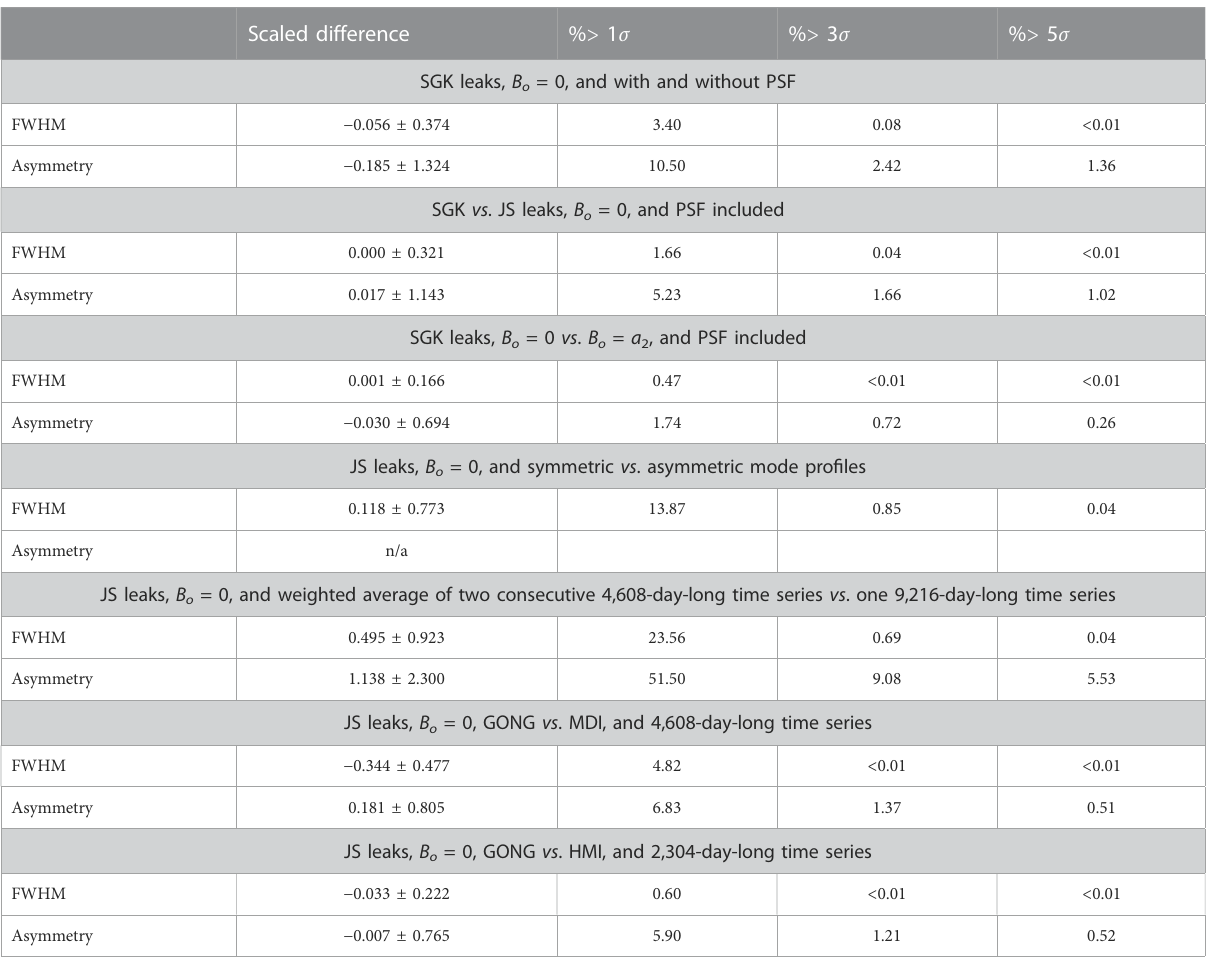
TABLE 2 Overall statistics when comparing mode characteristics derived using different fi tting leakage matrices of time